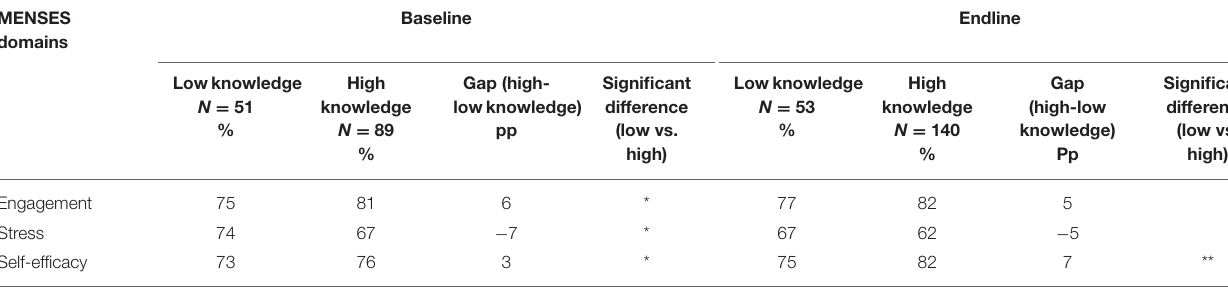
TABLE 10 | MENSES domains for girls with low SES by level of knowledge over time.